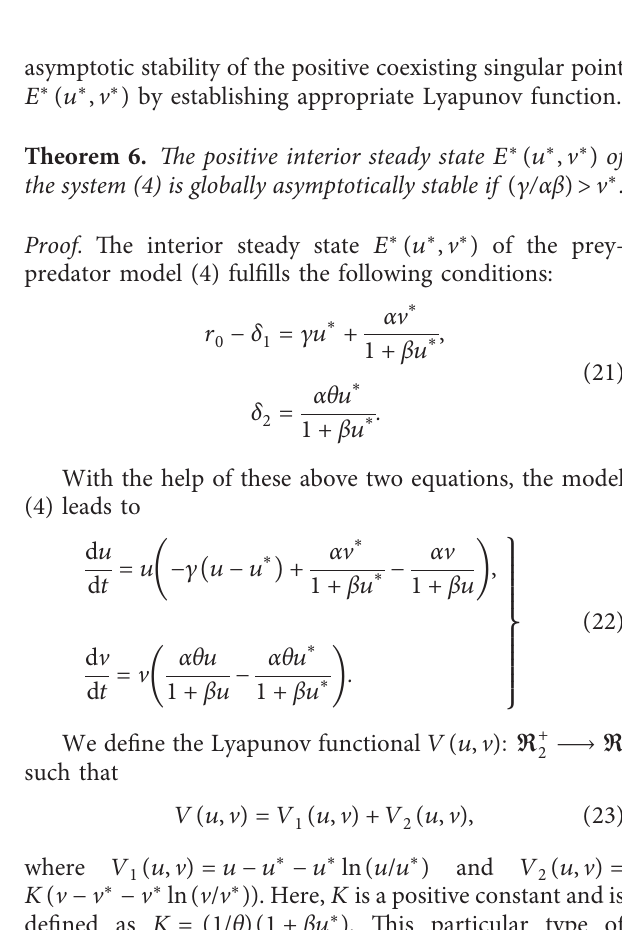
Figure 2: The stability region of the trivial singular state E , boundary singular state E , and the coexisting singular state E ∗ of (4), in the ( r 0 1 � 0 . 0125, c � 0 . 01, α � 0 . 8, θ � 0 . 4, and δ ∈ ( 0 , 0 . 1 ) and β ∈ ( 0 , 1 . 0 ) . Other parameter values are δ parameter-space where r 0 1 is locally asymptotically stable, but boundary singular point E figure, (i) within the blue colored region, the equilibrium point E 0 equilibrium E ∗ are unstable; (ii) within the green colored region, the equilibrium point E is locally asymptotically stable, but trivial equilibria E 1 interior equilibrium E ∗ are unstable; and (iii) within the red colored region, the interior equilibrium point E ∗ is locally asymptotically stable, but the trivial equilibrium E and boundary equilibrium E are 0 1